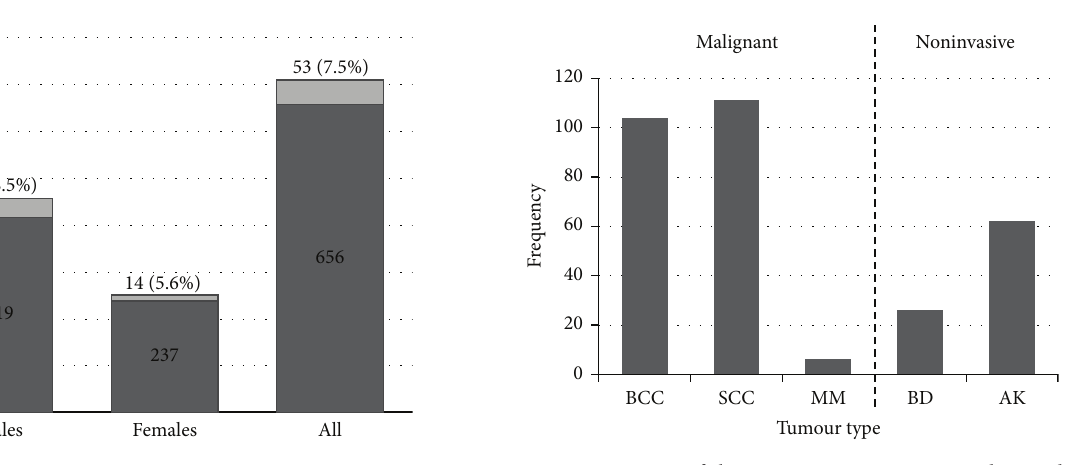
Figure 3: Frequency of skin tumour types among renal transplant recipients in the study population.